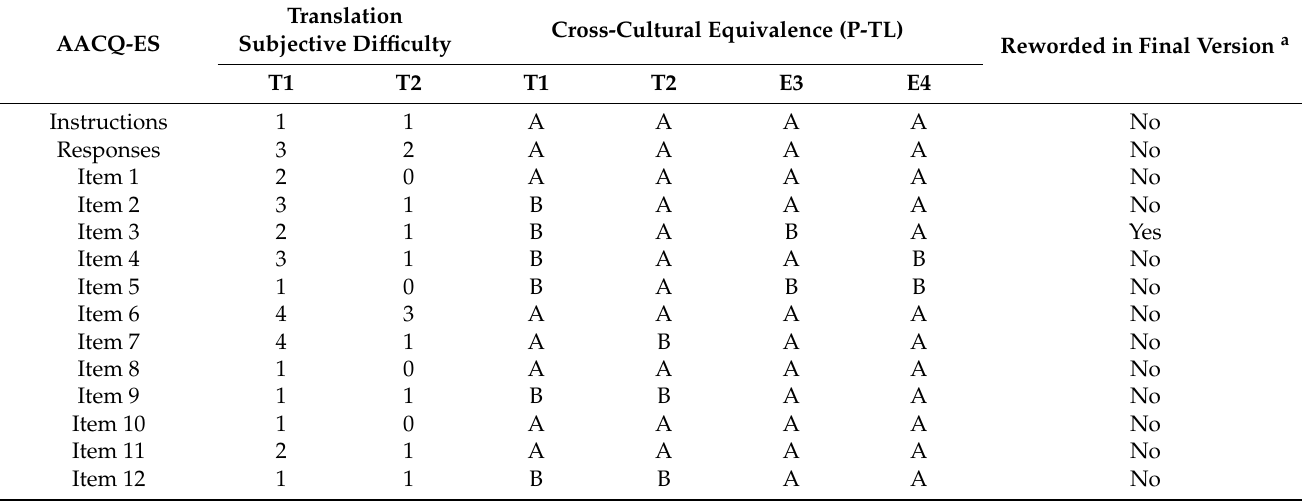
Table 1. Translation subjective difficulty and cross-cultural equivalence of the